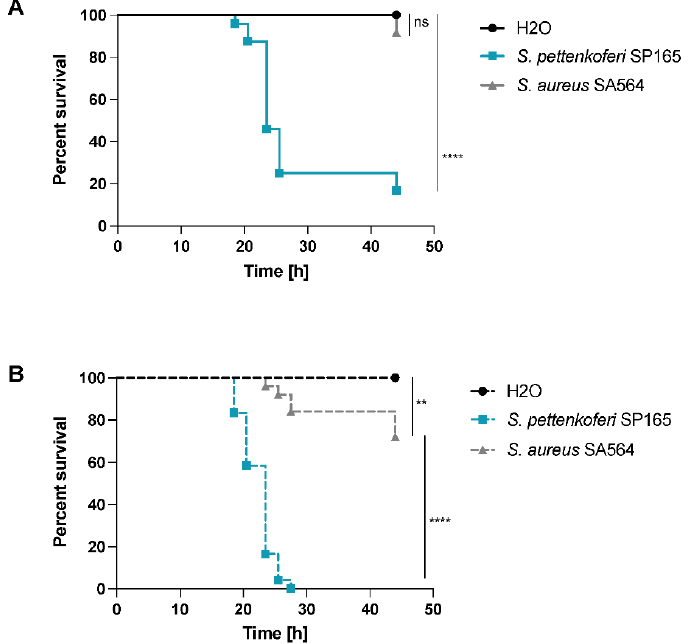
Figure 5. Virulence of S. pettenkoferi SP165 and S. aureus SA564 strains in zebrafish embryos. Kaplan–Meier representation of the survival of ( A ) healthy zebrafish embryos or ( B ) zebrafish embryos injured in the tail fin at 48 h post-fertilization (hpf) in a bath infected with S. pettenkoferi SP165 or S. aureus SA564 strains at 2.10 7 CFU/mL grown in exponential phase or “fish water” (negative control).